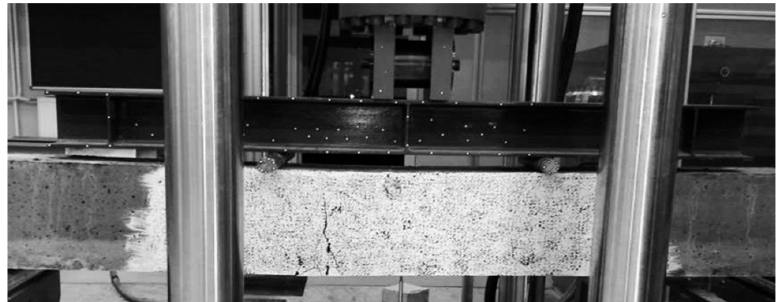
Figure 3. Experimental setup for the four-point static bending tests.